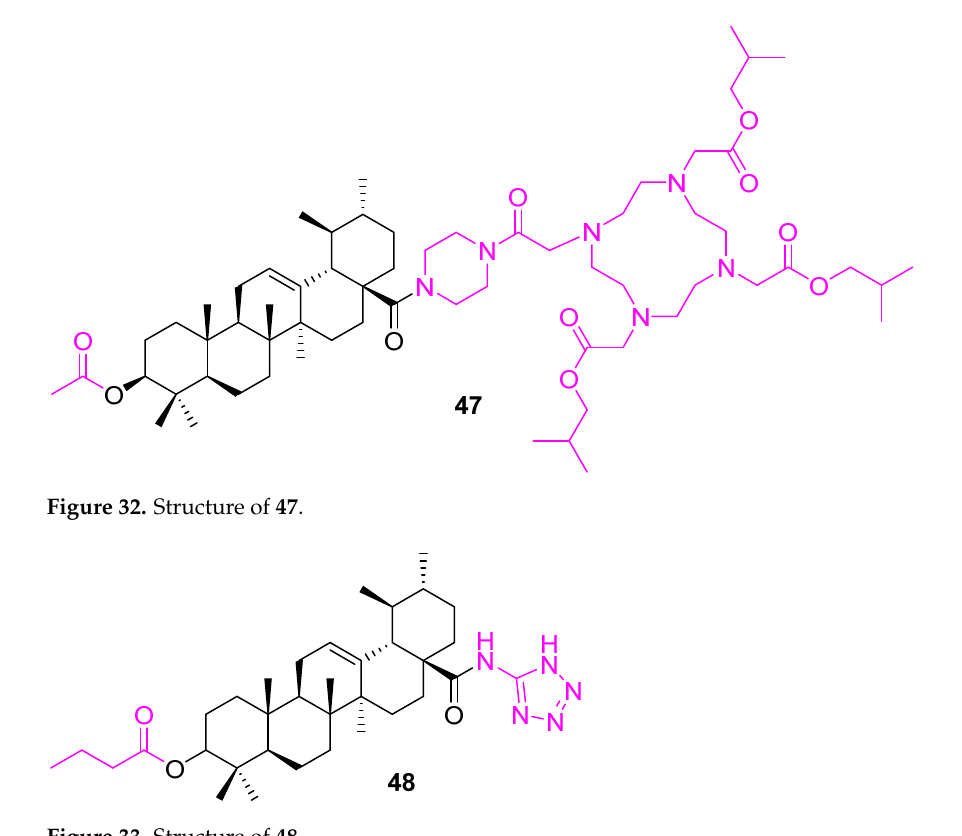
Figure 33. Structure of 48 .